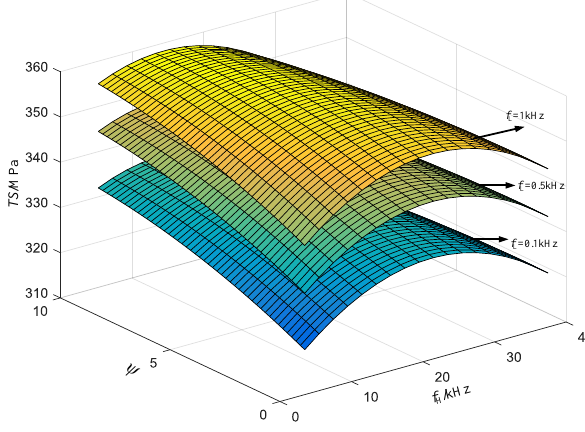
Figure 3. Response surface on tensile strength ( TS ).